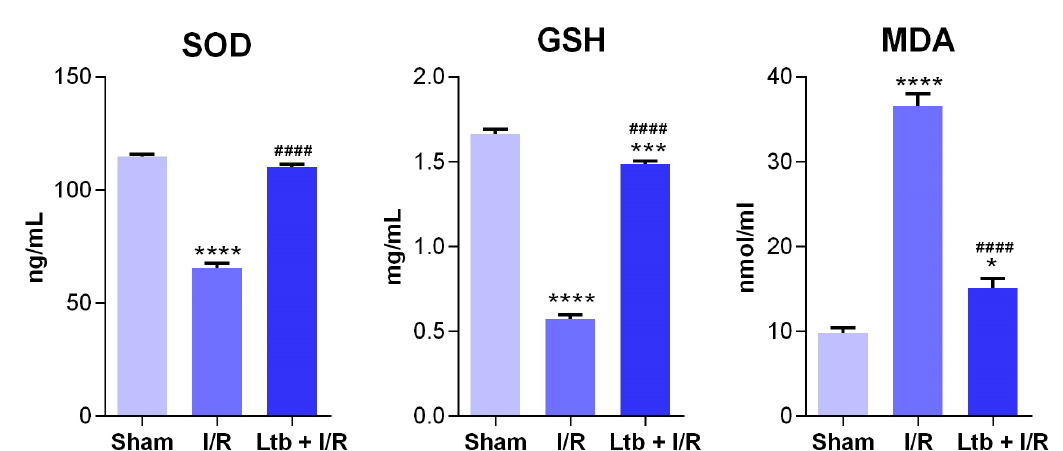
FIGURE 1 - The effects of lithium tetraborate the SOD, GSH and MDA levels on heart after I/R injury. Data are presented as mean ± SEM (n=7). * denotes significant differences between other studied groups and sham ( * : p<0.05, **** : p<0.0001), # denotes significant differences between other studied groups and I/R group ( #### : p<0.0001) by Tukey’s multiple range tests. Abbreviation used: I/R: Ischaemia/Reperfusion, Ltb: Lithium